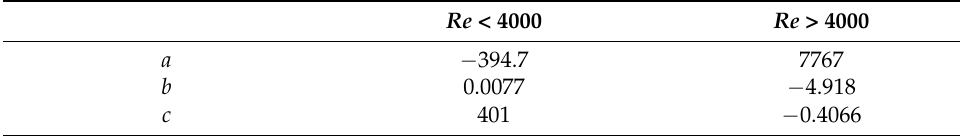
Table 4. Table of coefficients of Equation